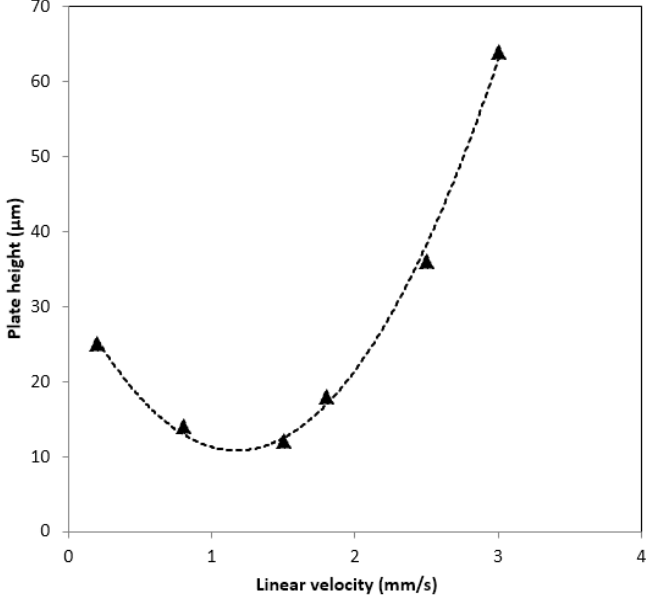
4 shows the optimized monolith (i.e., Column 7) stability, which exhibited a linear